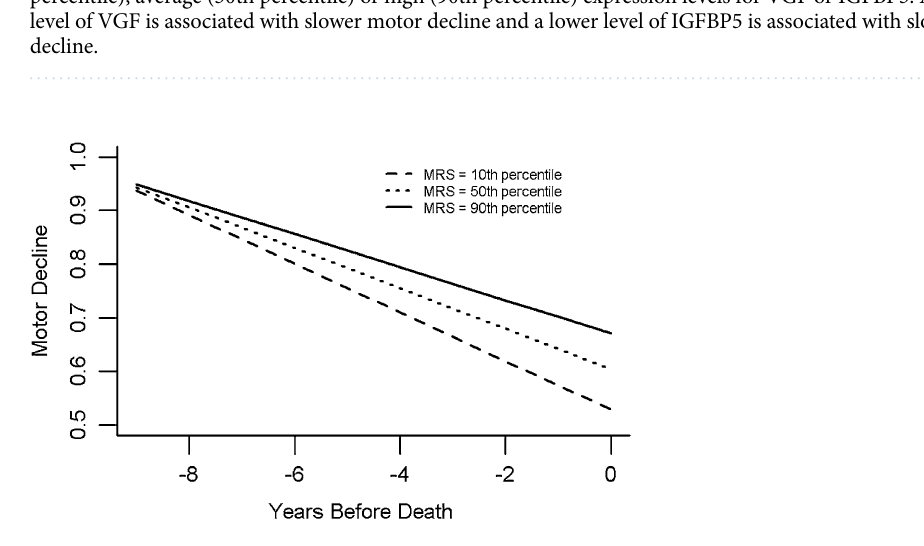
Figure 6. Motor resilience protein score is related to the annual rate of motor decline. Person-specific resilience is the overall balance of all peptides which drive residual motor decline. We calculated a person-specific motor resilience protein score based on the expression levels of the 20 proteotypic peptides associated with motor decline (Table 2A). The figure illustrates the model derived trajectory of motor decline for three average older adults with high (motor resilience protein 90th percentile: decline = − 0.031/year), average (motor resilience protein score 50th percentile: decline = − 0.038/year) and low (motor resilience protein score10th percentile: decline = − 0.045/year) motor resilience protein